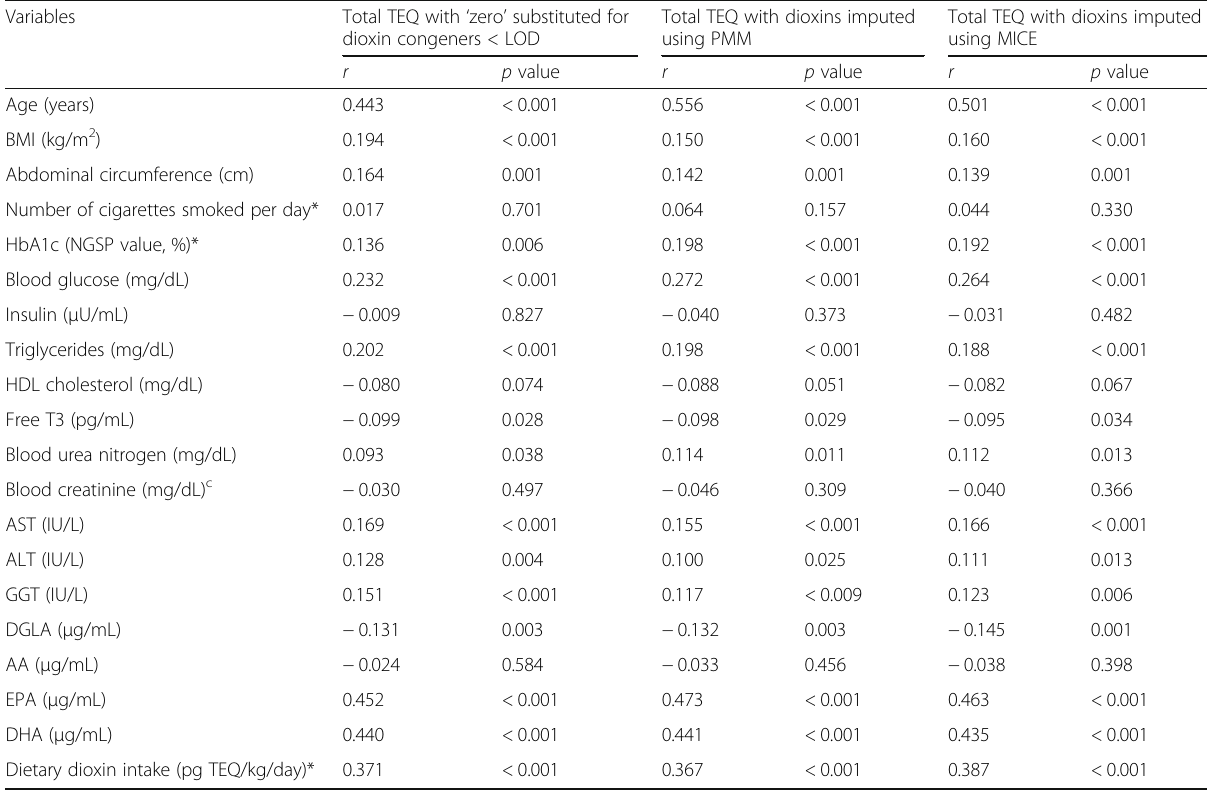
Table 3 Pearson ’ s correlation between log-transformed blood dioxins (in pg TEQ/g lipid) and health outcomes, SEDOCCH 2011 – 2016 Variables Total TEQ with ‘ zero ’ substituted for Total TEQ with dioxins imputed Total TEQ with dioxins imputed dioxin congeners < LOD using PMM using MICE